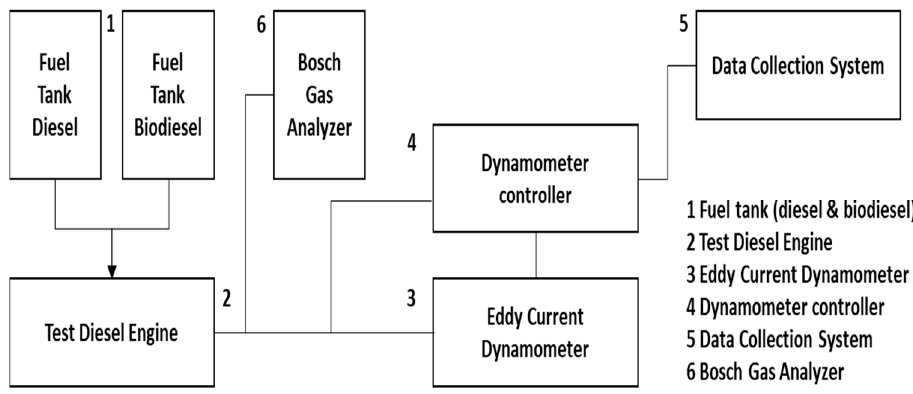
Table 1. Engine Specification.